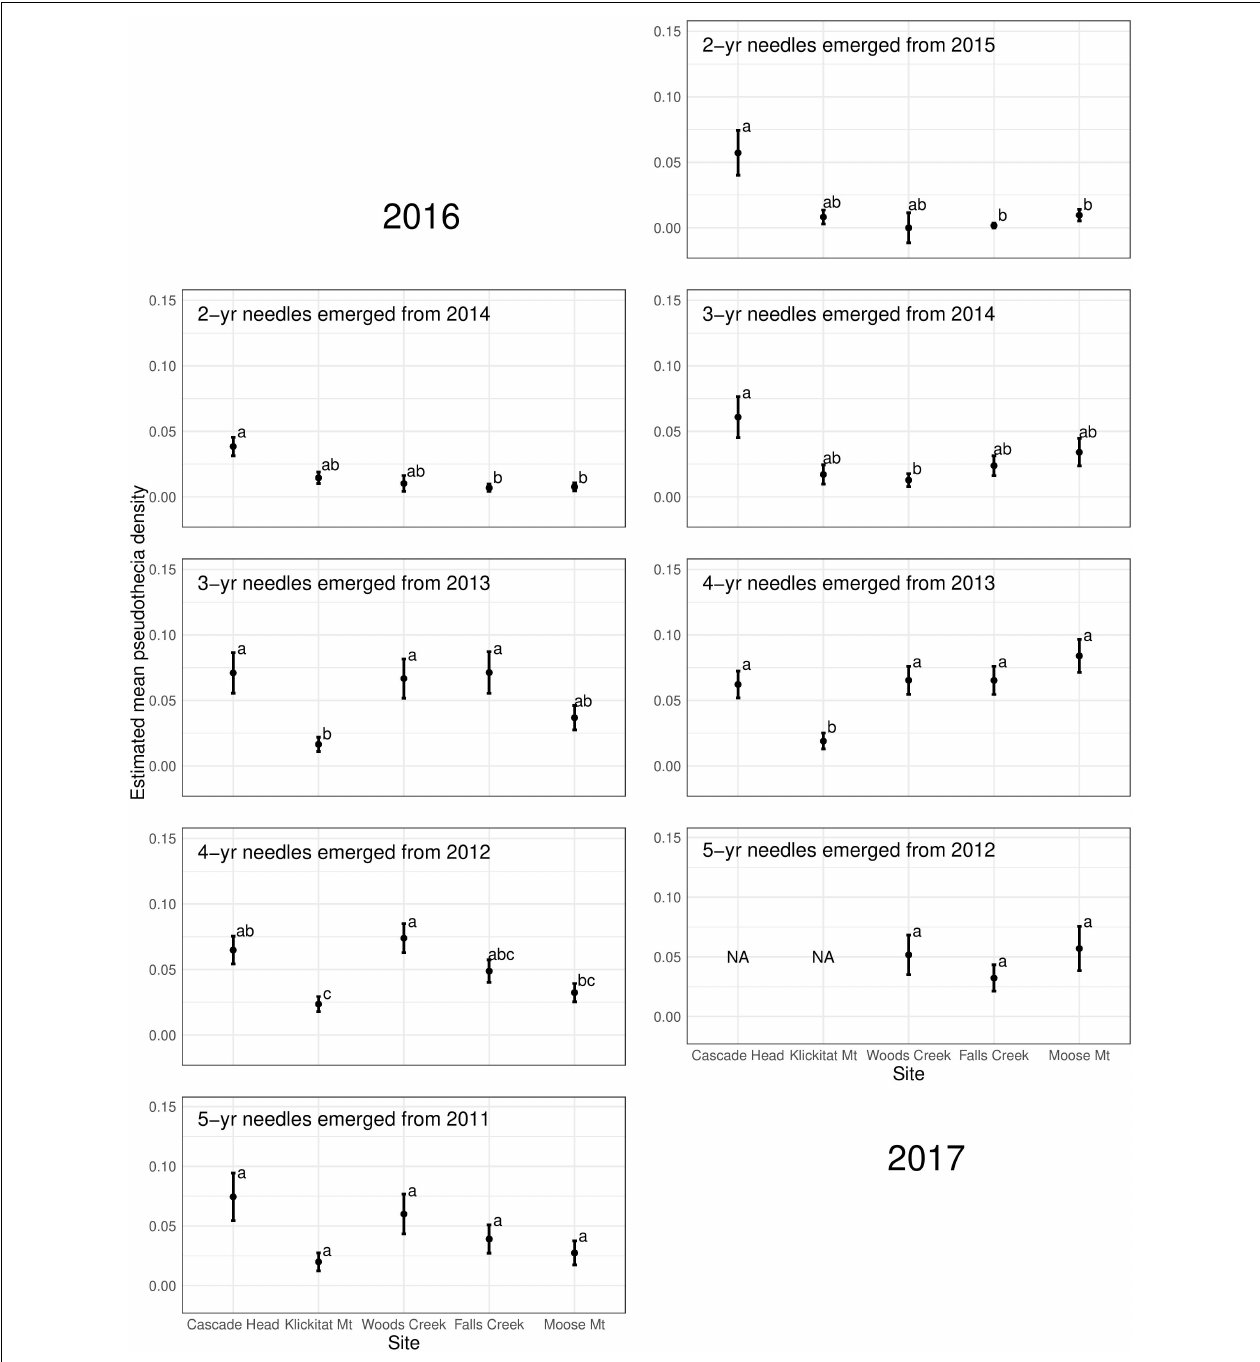
FIGURE 5 | Pseudothecia density by site for 2- to 5-year old needles in 2016 and 2017 from mature Douglas-fir trees in western Oregon. Sites listed on the X -axis are from coast (left) to inland (right). Different letters represent that the two groups are statistically different.